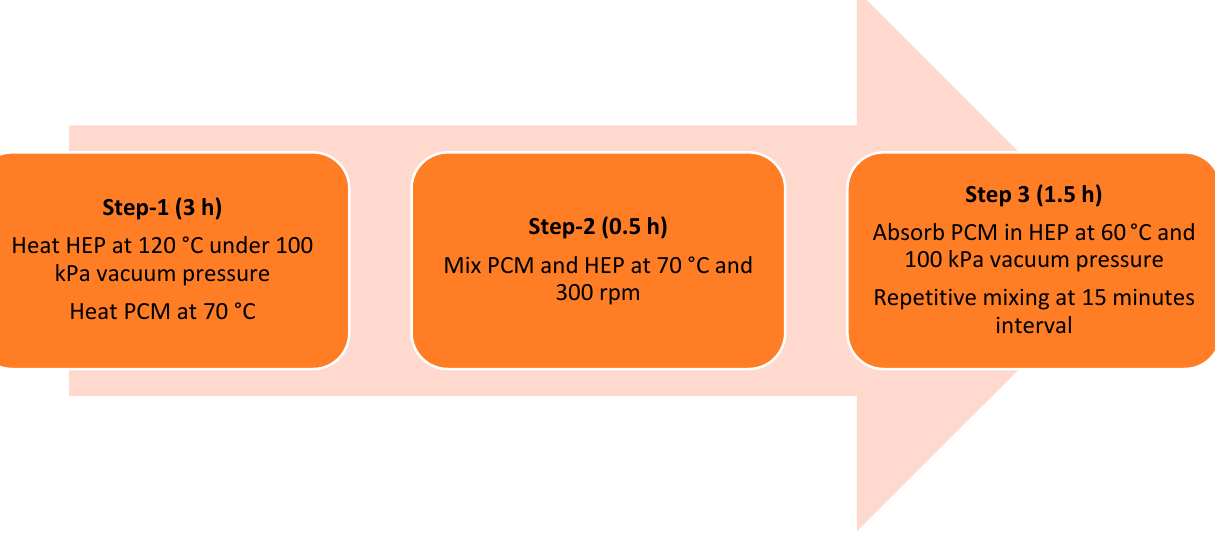
Figure 1. Steps of form-stable PCM (FSPCM) preparation .